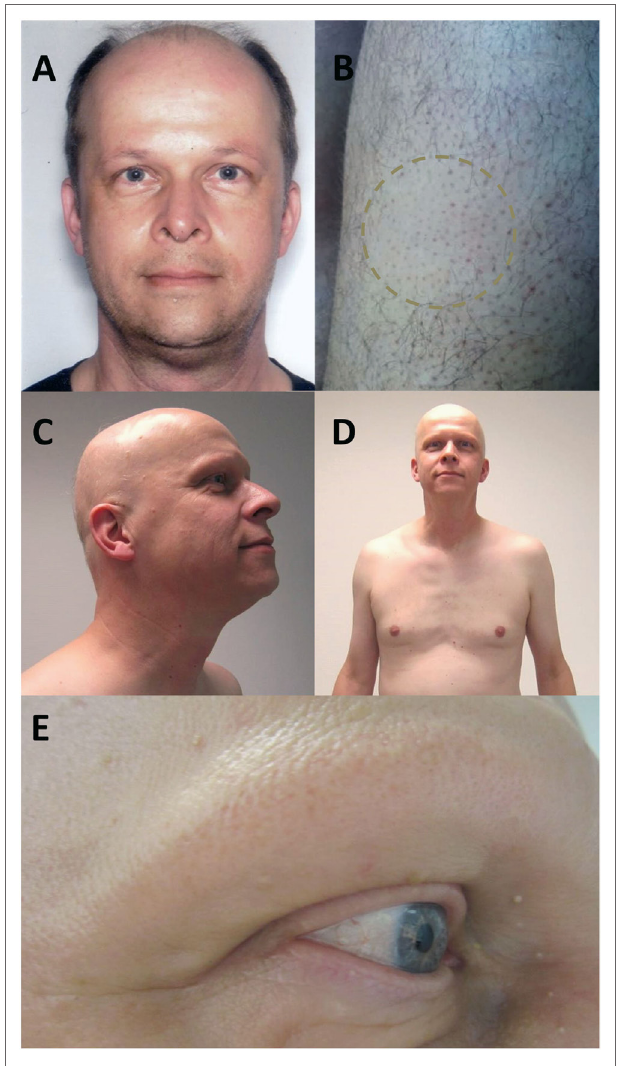
FiGURe 1 | Photograph of the patient before onset of alopecia, after first alemtuzumab cycle (a) . Six months after second alemtuzumab cycle, the patient presented with smooth, circular areas of complete hair loss at both thighs (B) . Three months later, the alopecia progressed to a complete loss of all scalp hair with a few remaining thin and pigmented residual hairs (C) and a patchy body hair loss including chest (D) , axillae, and pubic region. Eyebrows and eyelashes were extensively involved (e)